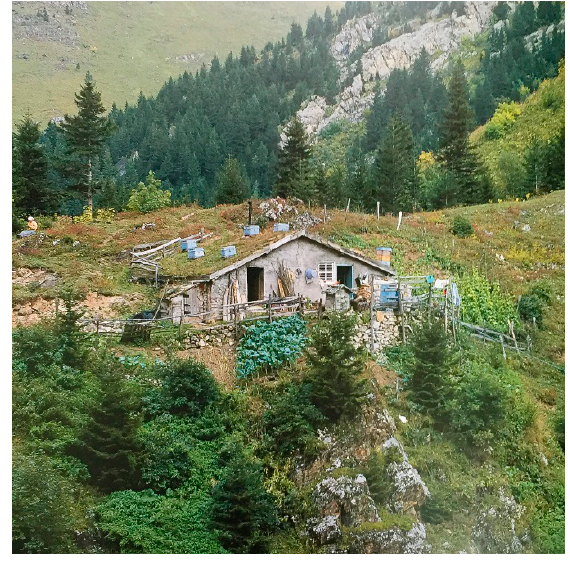
Figure 10. Vernacular housing hiding in the soil, Sürmene/Trabzon (Gür and Batur 2005).